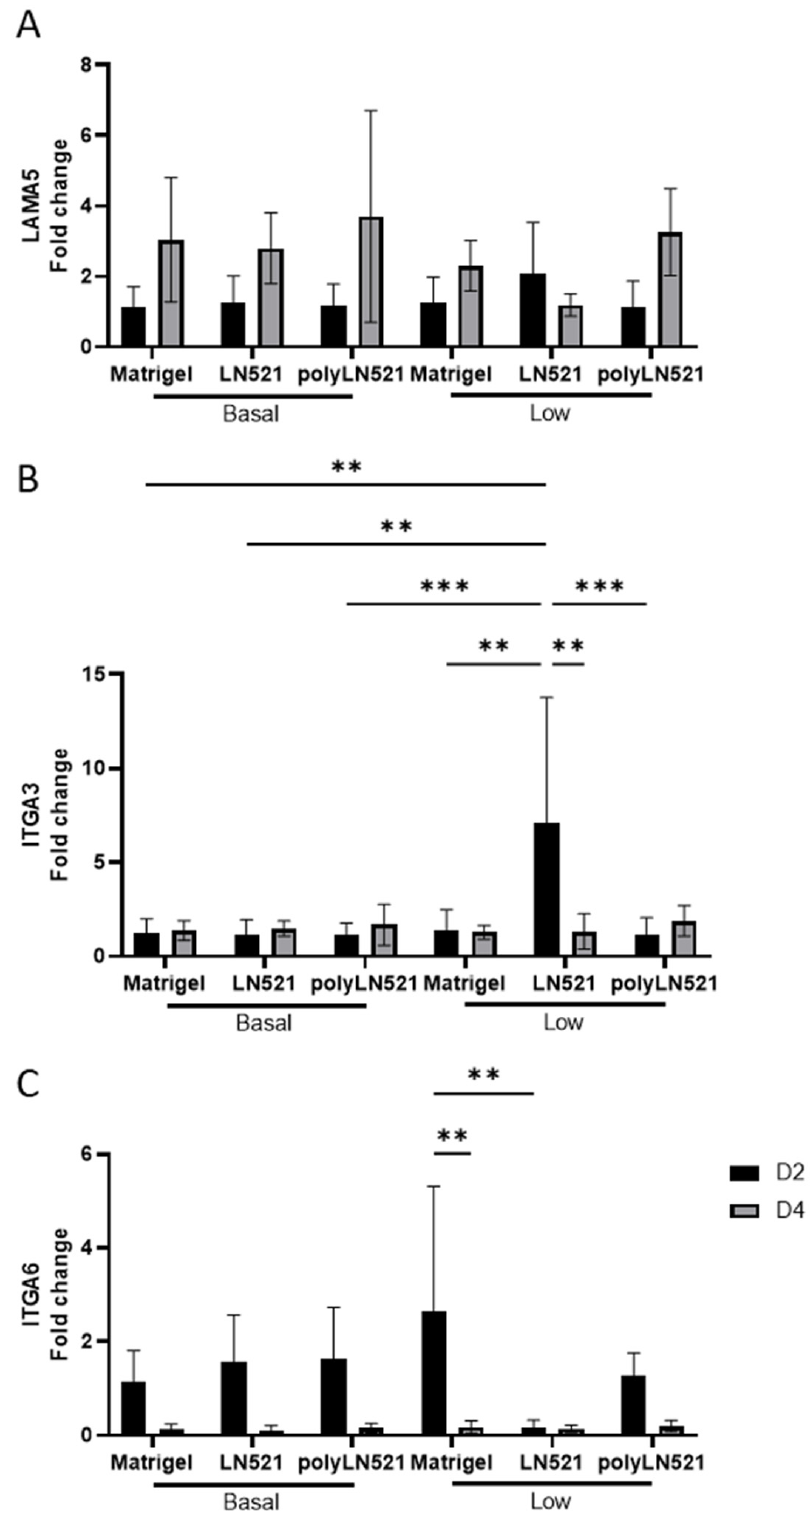
Figure 4. Gene expression indicative of extracellular matrix–cell interactions on days 2 and 4 in human induced pluripotent stem cells (hiPSCs) cultivated on coating systems with basal and low concentrations of Matrigel, LN521, or polyLN521. ( A ) Expression of LAMA5. ( B ) Expression of ITGA3. ( C ) Expression of ITGA6. n = 6 at day 2, n = 5 at day 4. ** p < 0.01; *** p <